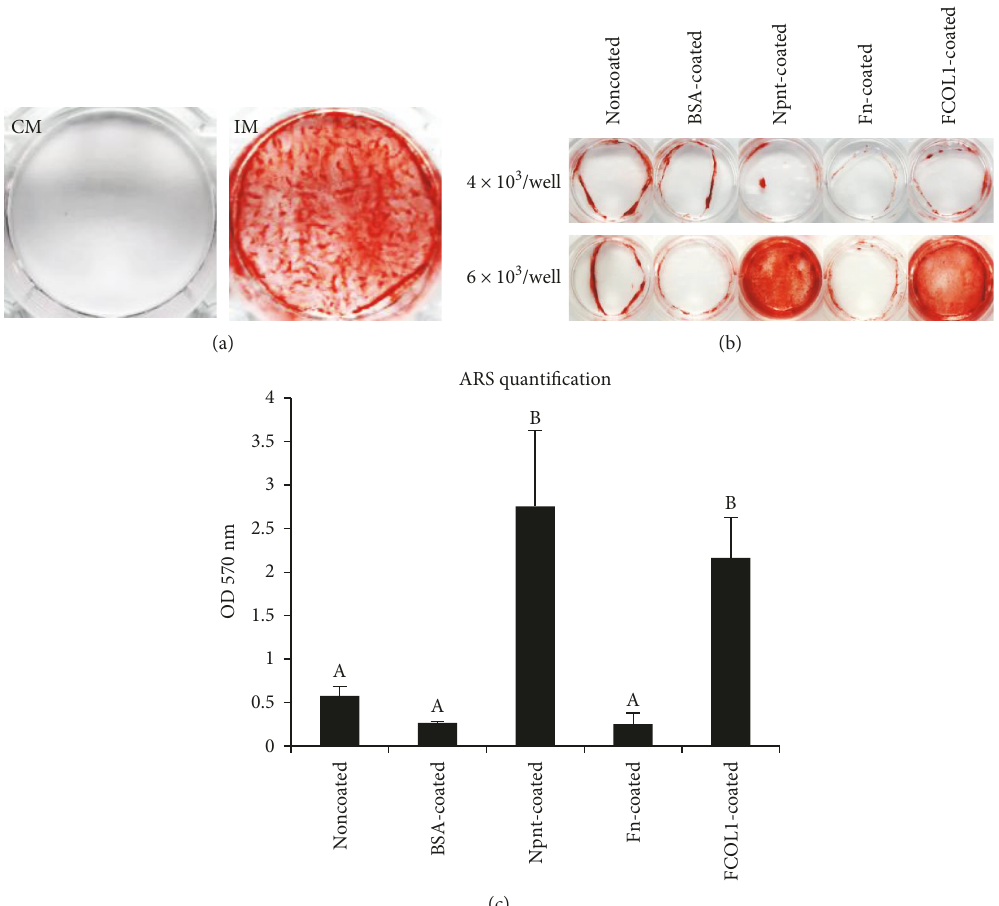
Figure 8: Evaluation of mineralization capacity in hDPSCs. (a) The mineralization capacity of hDPSCs was con fi rmed. hDPSCs (passage number 1) were seeded in 6-well plates (tissue culture-treated polystyrene, Iwaki) at the concentration of 3 × 10 4 /well in DMEM supplemented with 10% FBS and penicillin/streptomycin (50 U/mL penicillin; 50 μ g/mL streptomycin). Media were changed into DMEM supplemented with 5% FBS, penicillin/streptomycin and mineralization reagent (10 mM β -GP and 50 μ g/mL AA) (IM), or PBS vehicle (CM) at day four. The photo shows the alizarin red staining of cells at 23 days. (b) Alizarin red staining of hDPSCs (passage number 4) cultured on various protein-coated nontissue culture-treated polystyrene at day 30. hDPSCs were seeded to modi fi ed surfaces at the concentration of 4 × 10 3 /well (upper) or 6 × 10 3 /well (lower) in a 24-well plate (nontissue culture-treated polystyrene, Iwaki). Cells were cultured in DMEM supplemented with 10% FBS and penicillin/streptomycin. Mineralization reagent ( β -GP and AA) was added at day 4 with 5% FBS containing DMEM. (c) Quanti fi cation of alizarin red staining for the lower panel in (b). Signi fi cant higher level of mineralization of hDPSCs was detected in Npnt-coated and FCOL1-coated substrate(s). Di ff erent symbols represent signi fi cant di ff erences, p < 0 01 by post hoc Tukey ’ s HSD